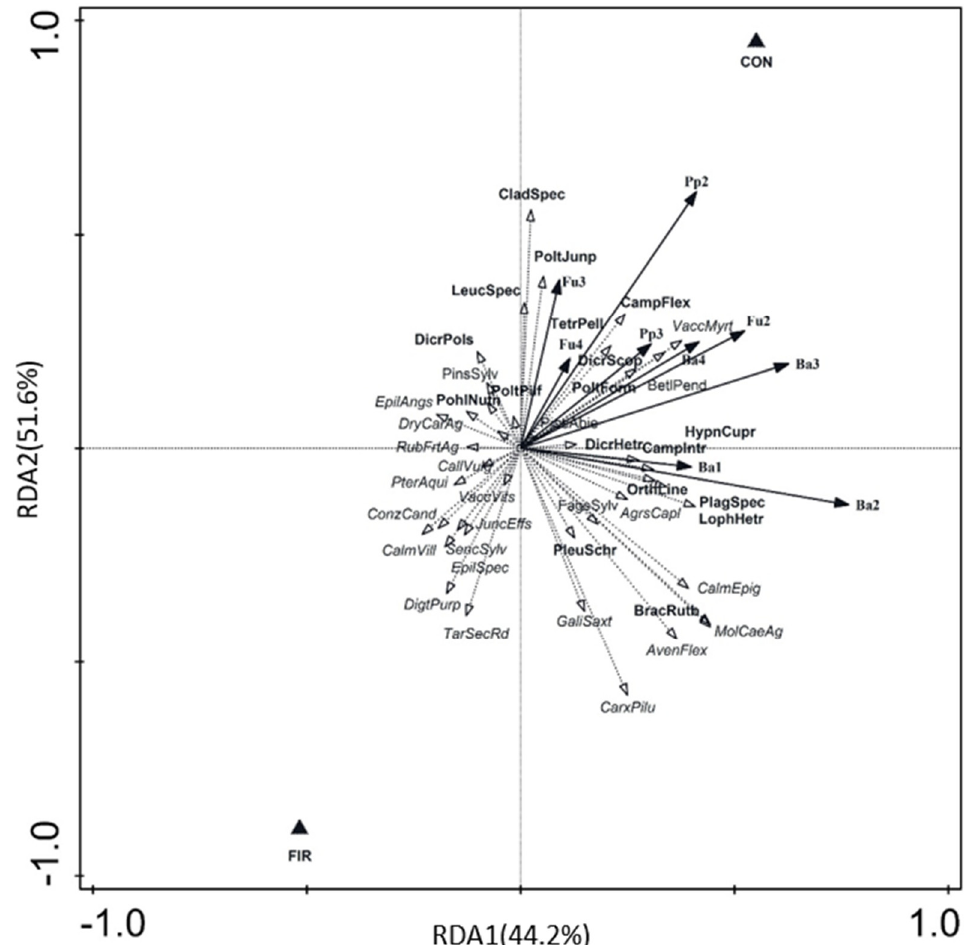
Figure 4. Ordination diagram based on RDA illustrating plant species (trees − normal, herbs − italics, mosses − bold) and nematode functional guilds composition of Ba, Fu, and Pp nematodes on forest sites affected by high (HIGH) and low (LOW) severe fires. Plants abbreviations used: